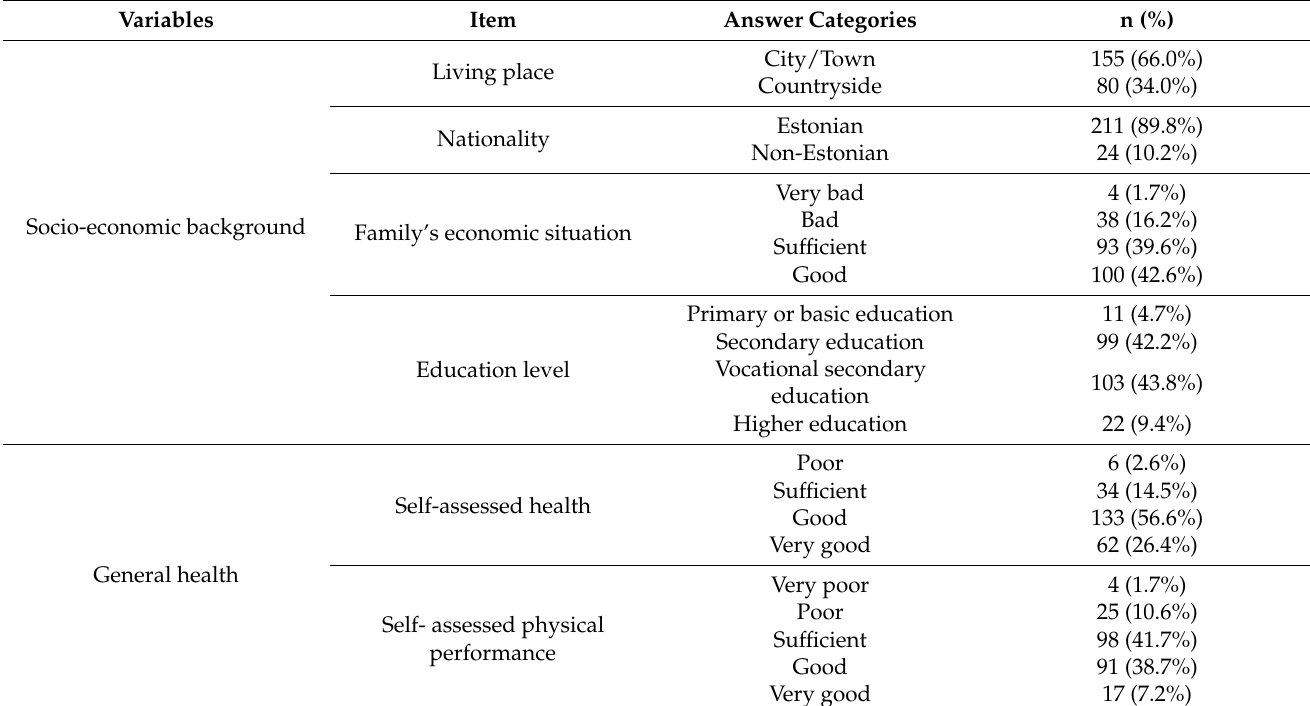
Table 2. Questionnaire data of the conscripts’ (n = 235) socio-economic background, subjective general health and health behavior